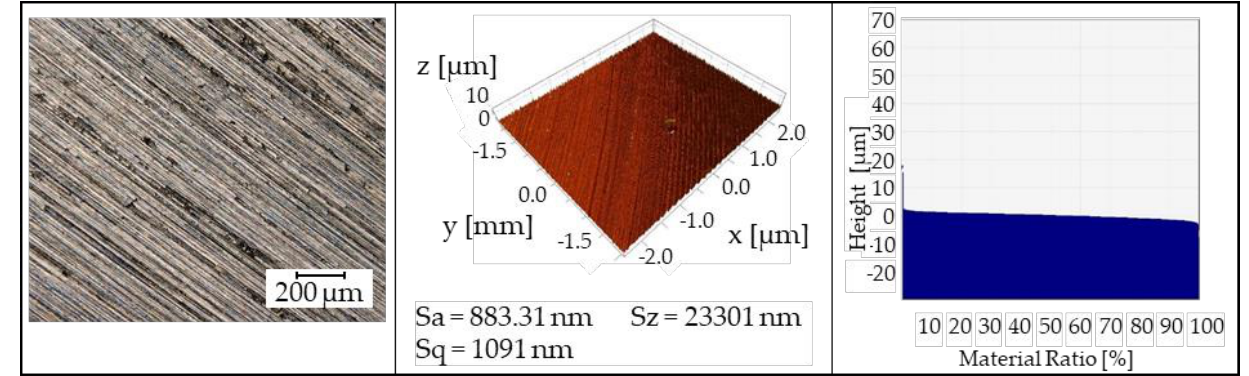
Figure 4. Surface characteristics of the milled surface.